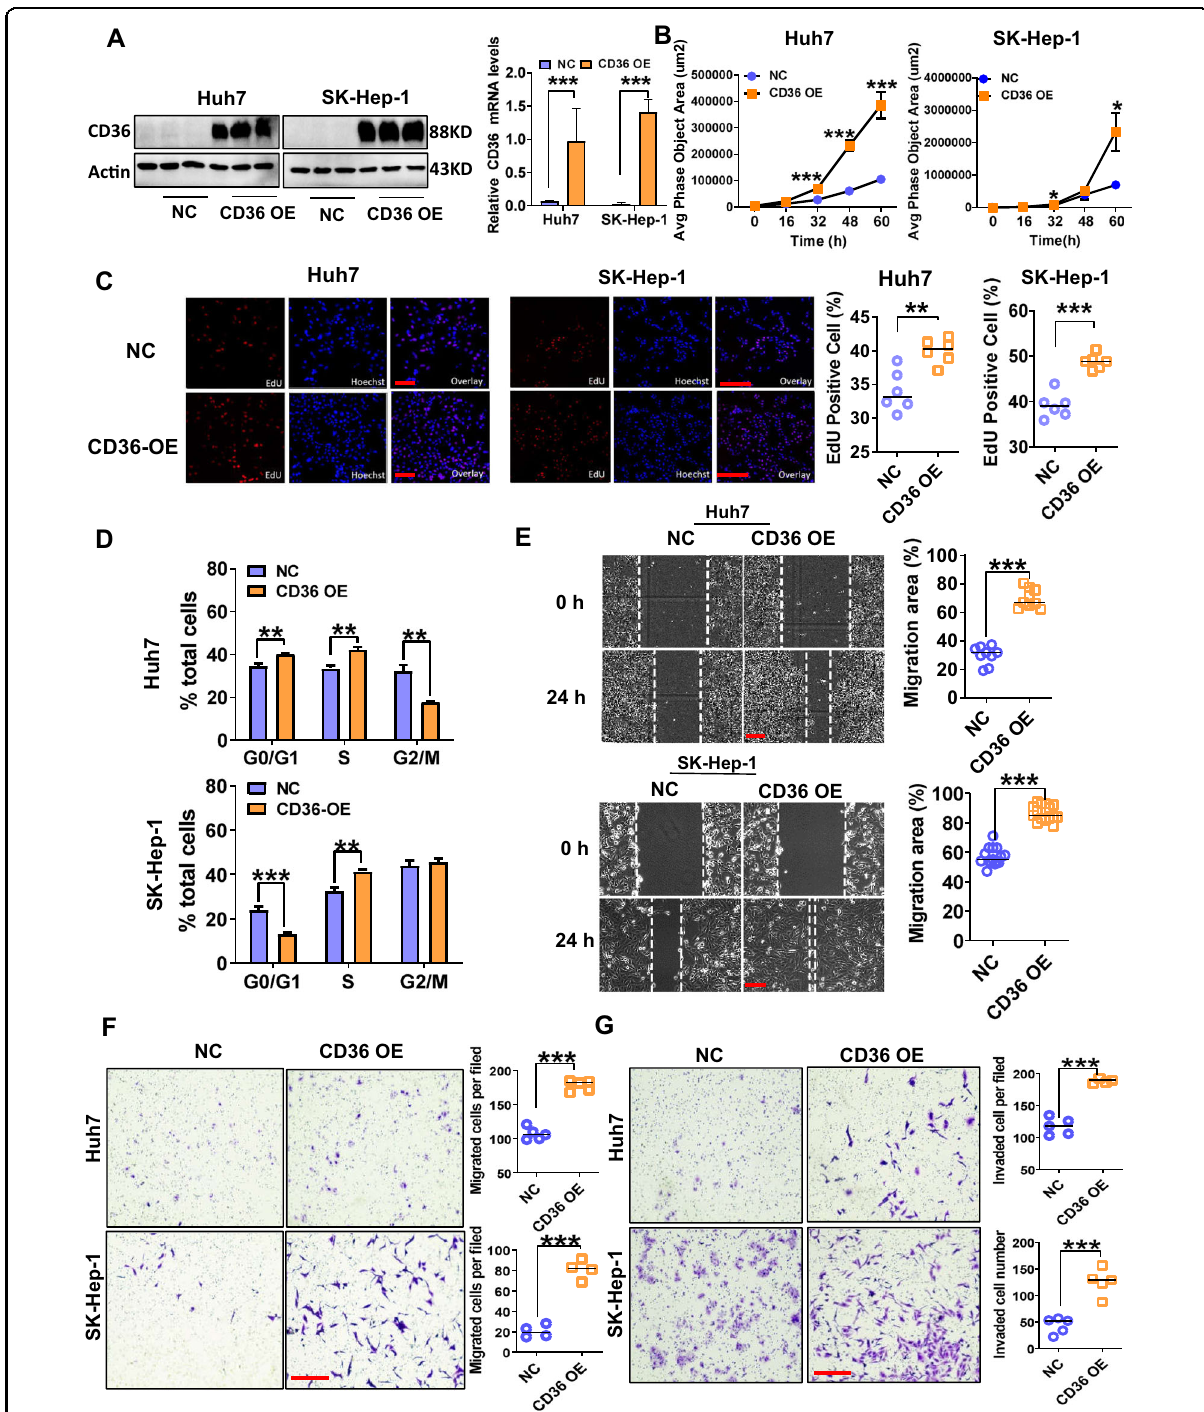
Fig. 3 CD36 overexpression has a positive impact on proliferation, migration, and invasion of HCC cells. CD36-overexpressed (CD36 OE) Huh7 and SK-Hep-1 cells were constructed by transfection of a recombinant lentivirus (Ubi-MCS-3FLAG-SV40-puromycin) containing CD36 cDNA or an empty vector as NC. A Western blotting analysis of CD36 levels in indicated HCC cells, actin was used as the control, the relative quanti fi cation of the blots was shown on the right ( n = 3). The proliferation of CD36 OE cells or control cells was measured by long time cell dynamic imaging system ( B ) and EdU assay ( C ) ( n ≥ 5). D Cell cycle analysis was performed after culture for 48 h using fl ow cytometer ( n = 3). E Scratch-wound cell migration assay of CD36 OE or control cells ( n = 5). Cell migration ( F ) and invasion ( G ) ability was evaluated by transwell assays ( n = 5). All data are presented as mean ± SD. * P < 0.05, ** p < 0.01, and *** p < 0.001 compared with the NC group. Bar = 100 μ m ( C , E – G ). P -value was calculated using Student ’ s t